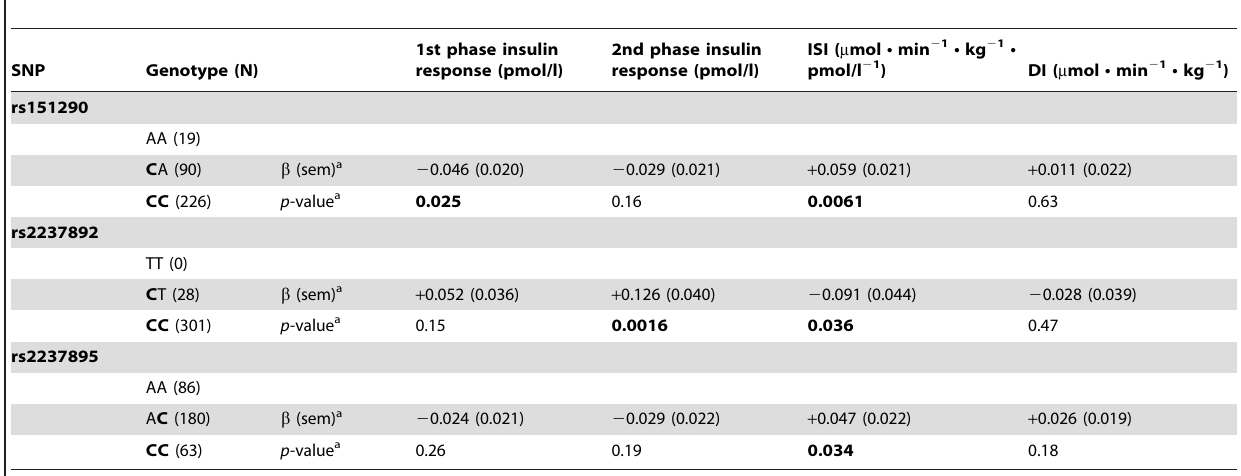
Table 3. Effect of KCNQ1 variants rs151290, rs2237892 and rs2237895 on beta-cell function as assessed with hyperglycaemic